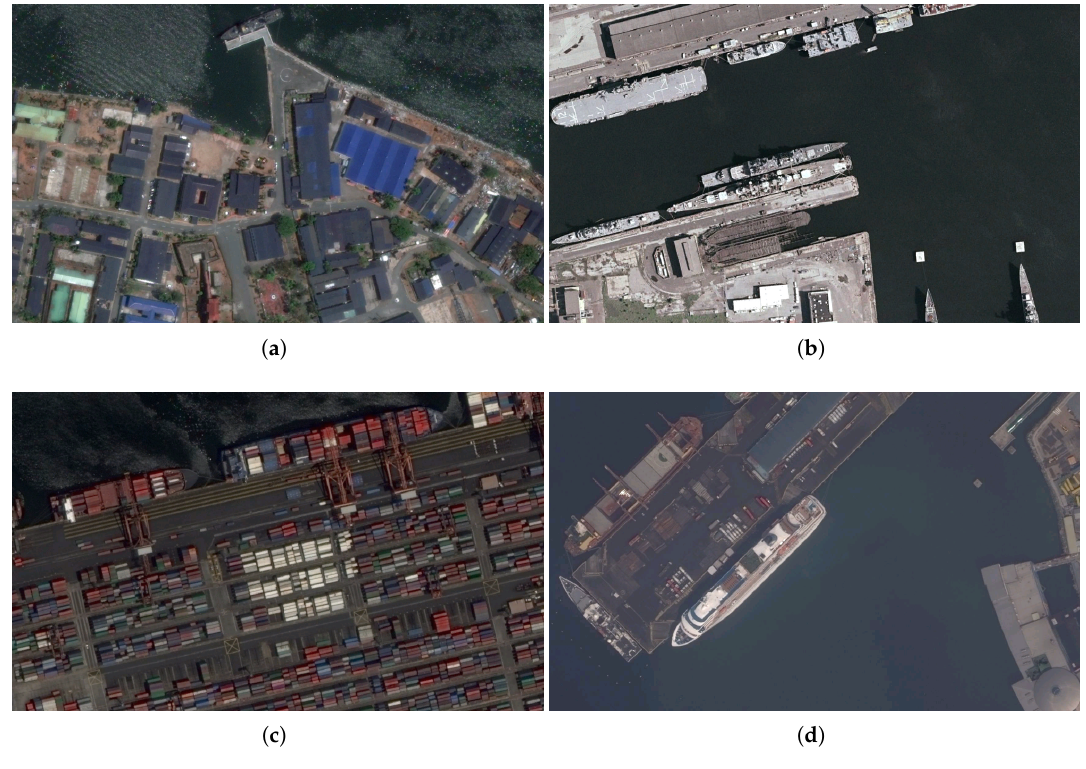
Figure 9. Some remote sensing ship images in